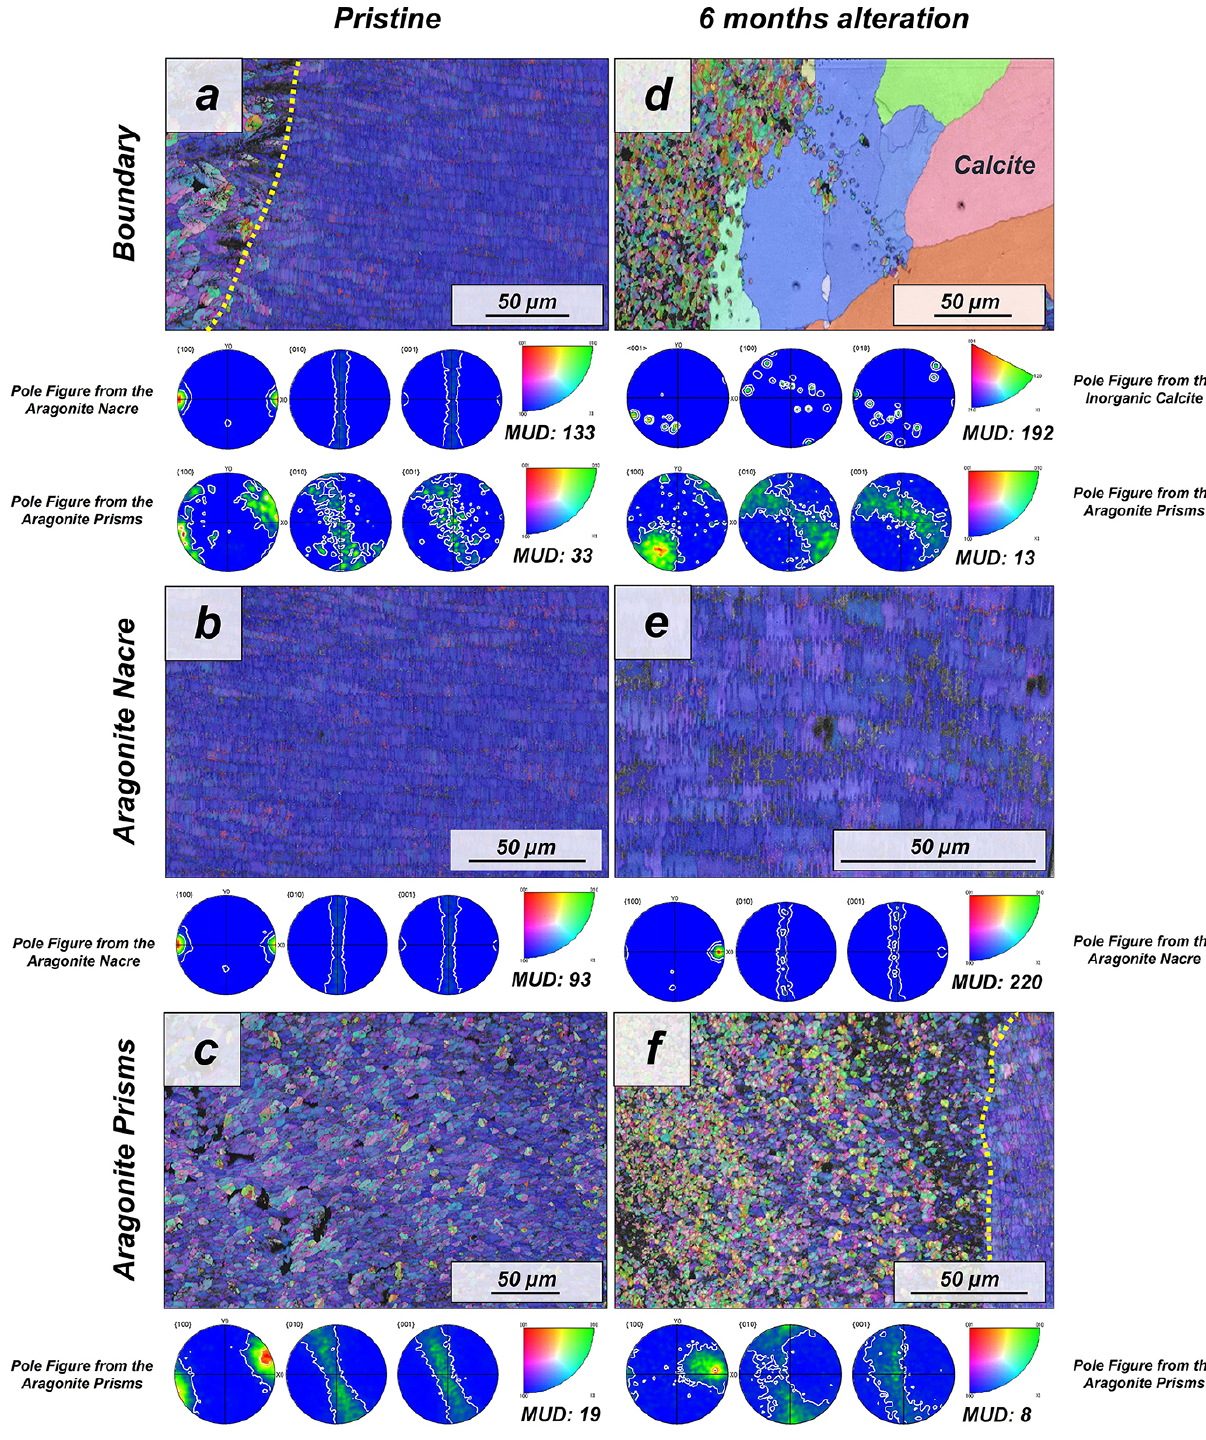
Figure 3. EBSD colour-coded orientation maps with their corresponding pole figures depicting the microstructure and texture of biogenic aragonite of the (a–c) pristine and (d–f) altered shells of the gastropod Haliotis ovina . The strength of crystal co-orientation is given with the MUD value, which is shown for each EBSD scan. Hydrothermal alteration of Haliotis ovina induces the replacement of large parts of the prismatic aragonite by non-biogenic calcite concomitant to a decrease in the MUD value of the untransformed aragonite prisms. Though the nacreous layer is not replaced by calcite, its MUD value increases from 93 to